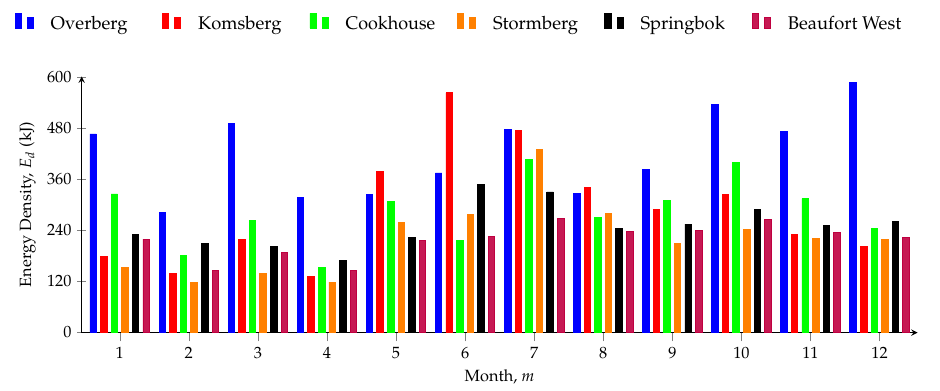
Figure 11. Monthly energy density of the wind REDZs.